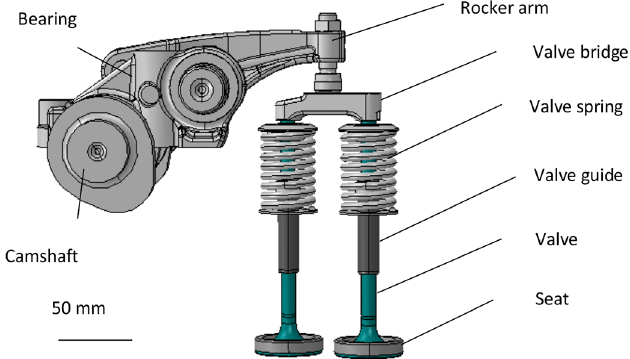
Fig. 5. Description of the valve train for the valve actuation.